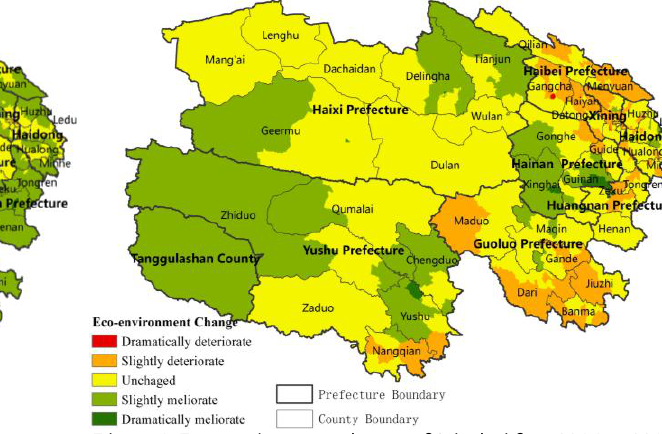
Figure 3. Eco-environment status of Qinghai in 2016 Figure 4. Eco-environment change of Qinghai form2014 to 2016